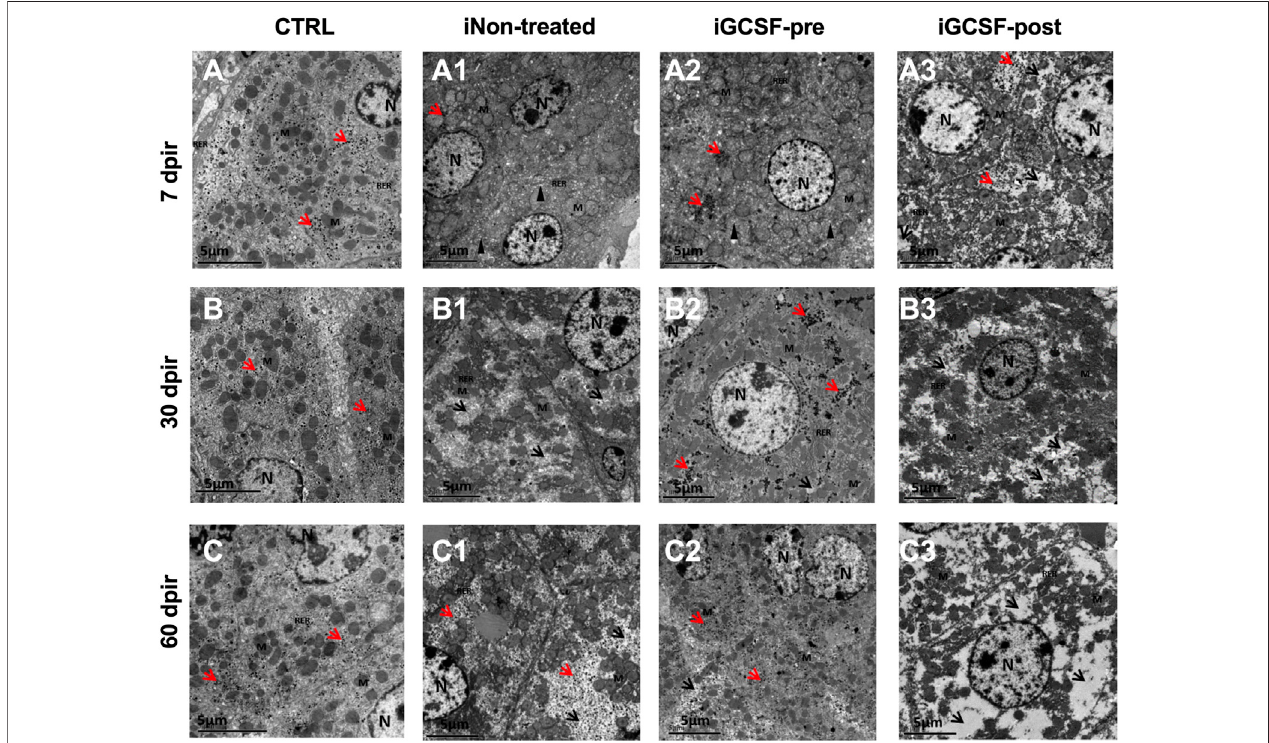
FIGURE 7 | Electron micrographs representative of transmission electron microscopy analysis (TEM). TEM images of CTRL group (A – C) showed well-condensed cytoplasmwithseveralorganelles,well-preservedmitochondria,roughendoplasmicreticulum,anddistributedglycogengranules.iNon-treatedGroup (A1 – C1) in7dpir (A1) showed more evident smooth endoplasmic reticulum (SER) cisterns, ruptured mitochondria, and loss of ridges, in addition to the rarer cytoplasm. At 30 (B1) and 60 (C1) dpir, a rarer cytoplasm was observed with an absence of organelles, mitochondria with rupture of the outer membrane, absence of mitochondrial ridges, and reduction of glycogen granules. In the iGCSF-pre (A2 – C2) group, with 7 dpir (A2) , well-condensed cytoplasm was observed with preserved mitochondria, RER, glycogen granules, similar to the CTRL group, but with more evident SER cisterns. With 30 (B2) and 60 dpir (C2) , a large amount of glycogen granules, reduction of the cisterns of SER, few regions of rare fi ed cytoplasm and well-preserved mitochondria were observed. In the iGCSF-post Group (A3 – C3) , at all times analyzed, rare fi ed cytoplasm, degraded, ruptured, and crested mitochondria, fragmented RER, and presence of glycogen granules were only observed in 7 dpir (A3) . N, nuclei; M, Mitochondria; RER, rough endoplasmic reticulum; SER: smooth endoplasmic reticulum; Arrowhead, dilated smooth endoplasmic reticulum cistern; Red arrow, glycogen granules; Black arrowhead, rare fi ed cytoplasm. ( n (cid:1) 5 per group). Scale bars: 5 µm.